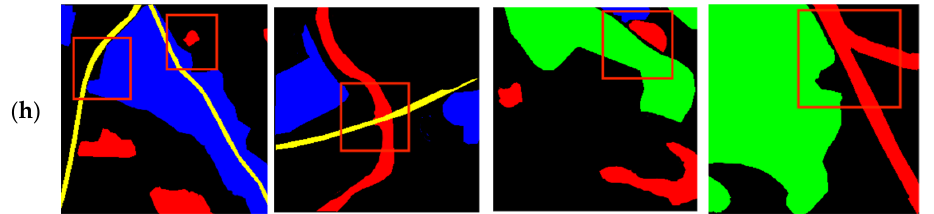
Figure 8. Model prediction results: ( a ) SAR image, ( b ) optical image, ( c ) tag image, ( d ) No. 1, ( e ) No. 2, ( f ) No. 3, ( g ) No. 4, ( h ) No. 5.